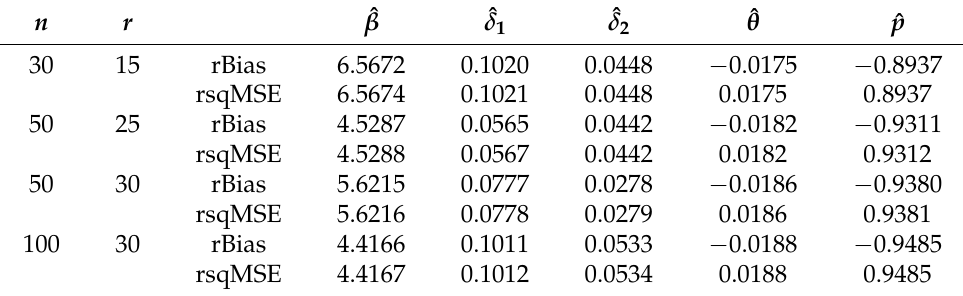
Table 8. The rBias and rsqMSEs of MLEs for p =